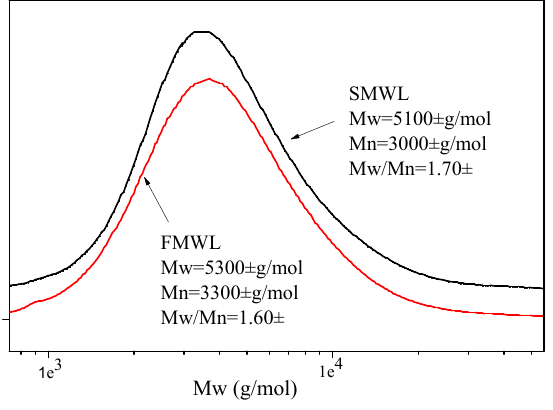
Figure 1. GPC chromatograms of FMWL and SMWL fractions.